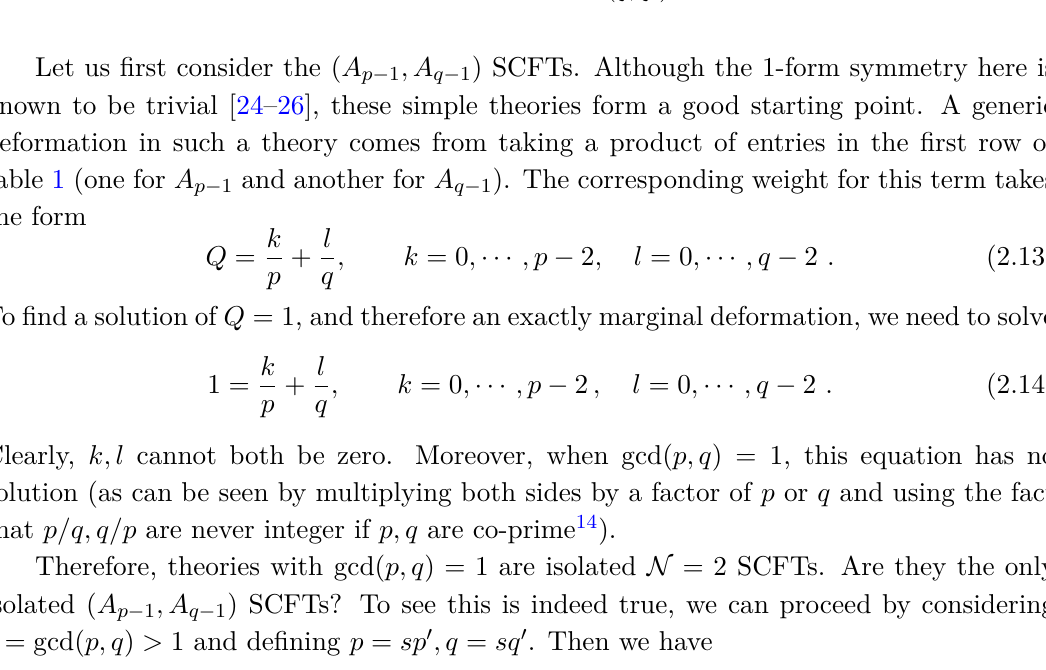
Table 1 . Useful data for the ( g , g 0 )